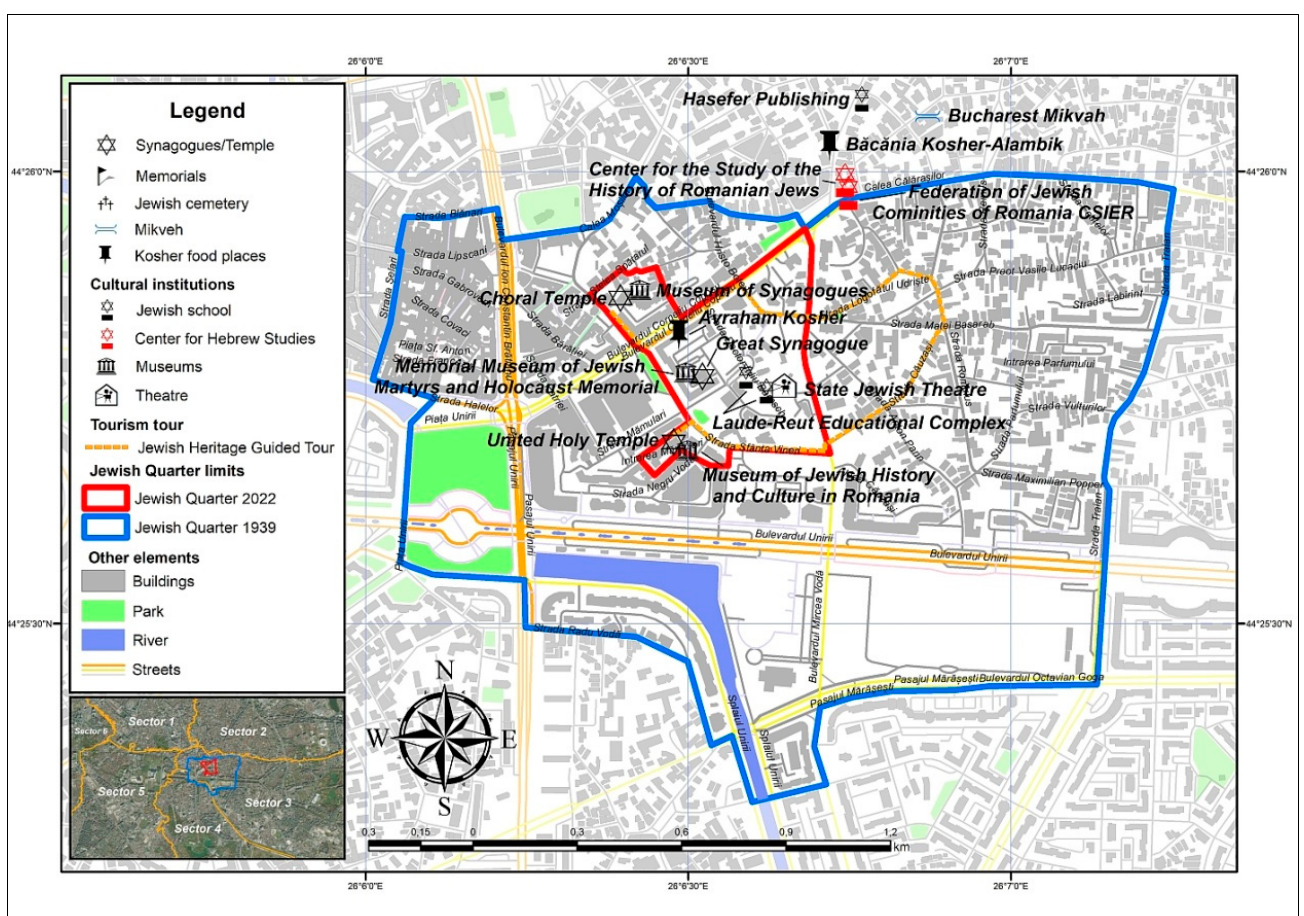
Figure 3. Distribution of tourist attractions in the delimited perimeter of the Jewish Quarter (1939/2022). Source: author, 2022.